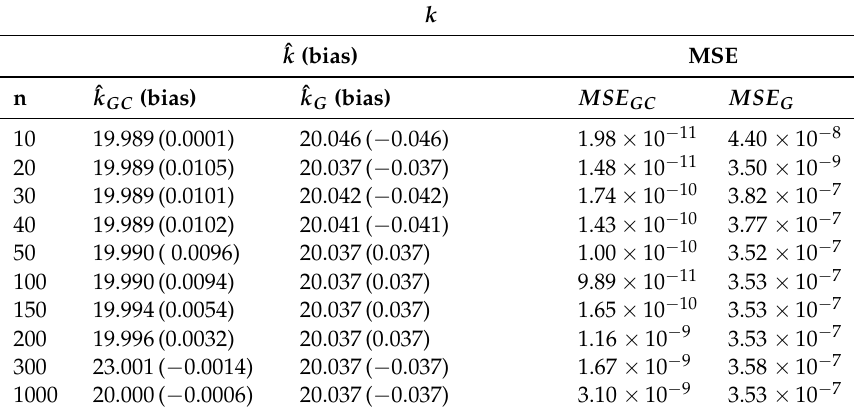
Table 6. MLEs of k with the conjugate gradient method and gradient